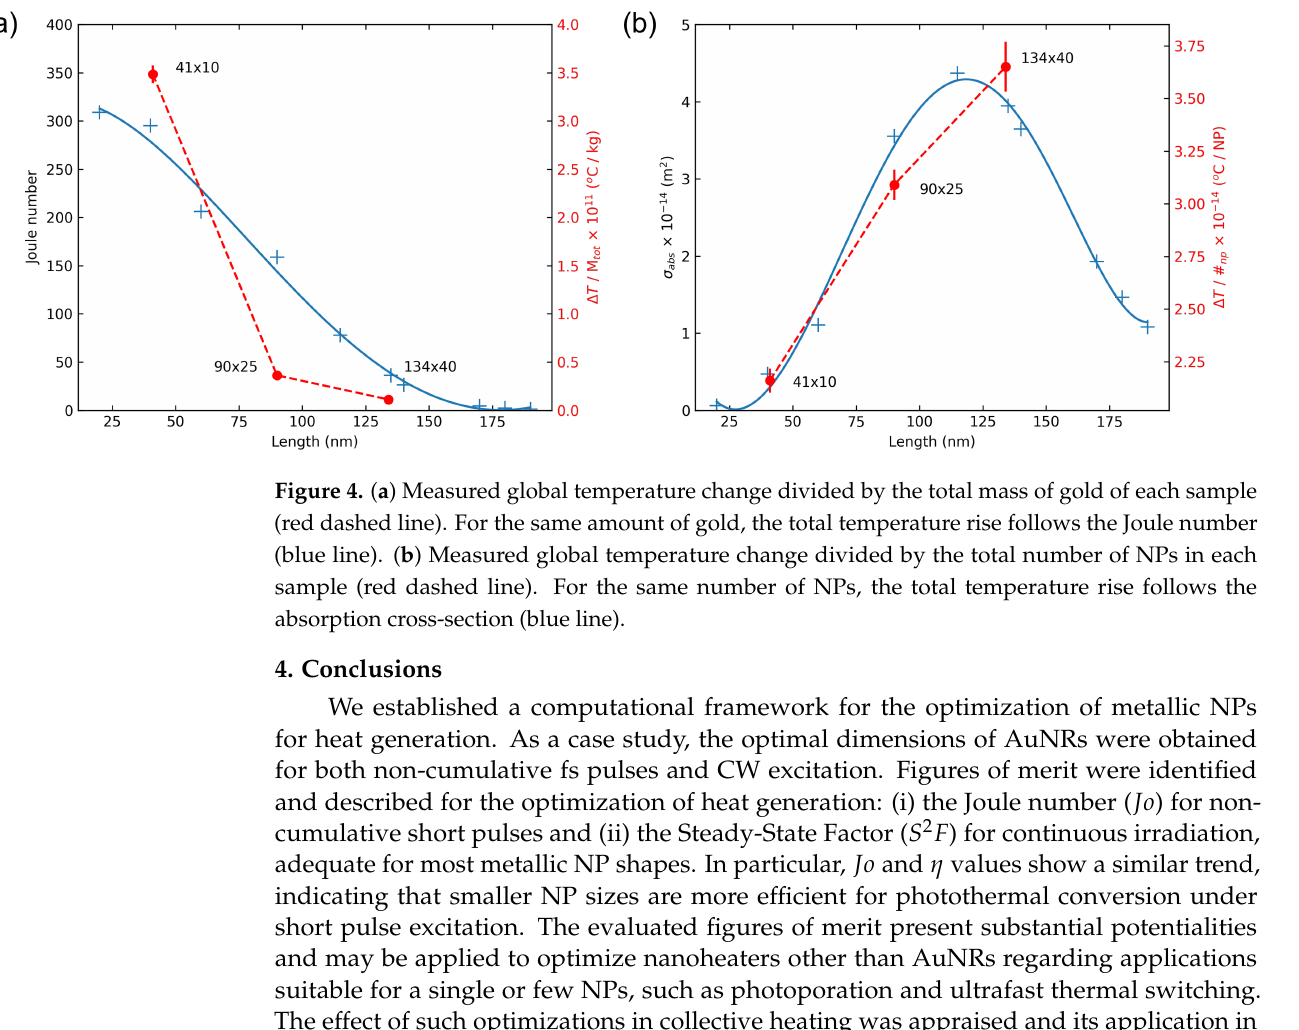
Figure S4: First sample measurement. Blue: 40 × 10 nm, Orange: 90 × 25 nm and Red: 134 × 40 nm. Figure S5: Second sample measurement. Blue: 40 × 10 nm, Orange: 90 × 25 nm and Red: 134 × 40 nm. Figure S6: Third sample measurement. Blue: 40 × 10 nm, Orange: 90 × 25 nm and Red: 134 × 40 nm. Table S1: Preparation of colloidal NP samples. Derivation of equations referenced in the